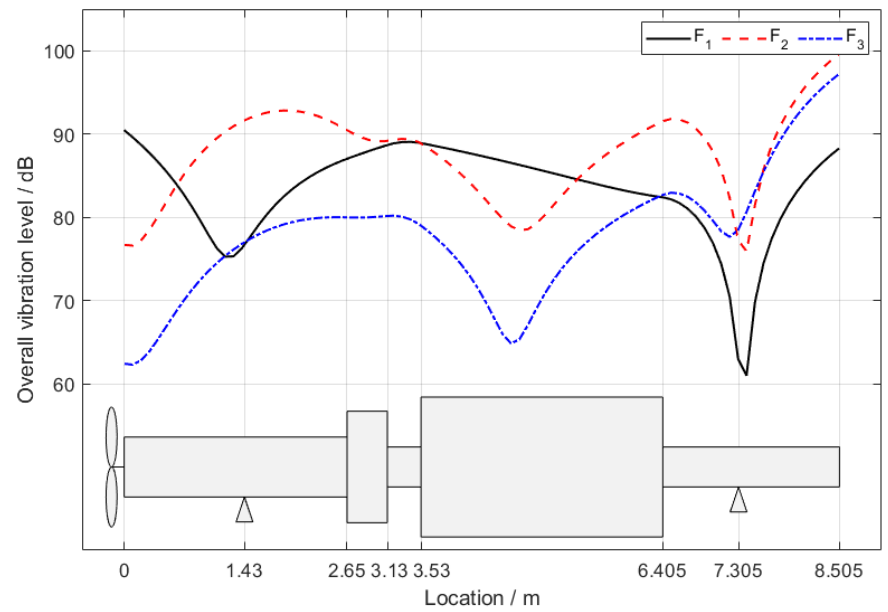
Figure 9. Transverse vibration response of podded propulsor shafting system under different radial excitation point positions. The calculation range of the overall vibration level is 0–160 Hz.